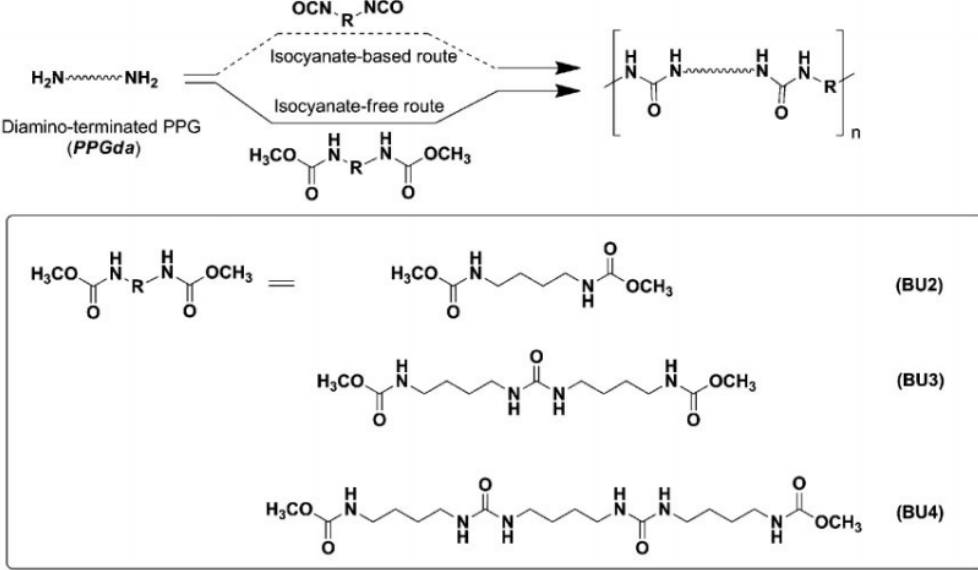
Figure 36. Synthesis of PUs from dicarbamates and diamino-terminated PPG via an isocyanate-free route. From reference [60].